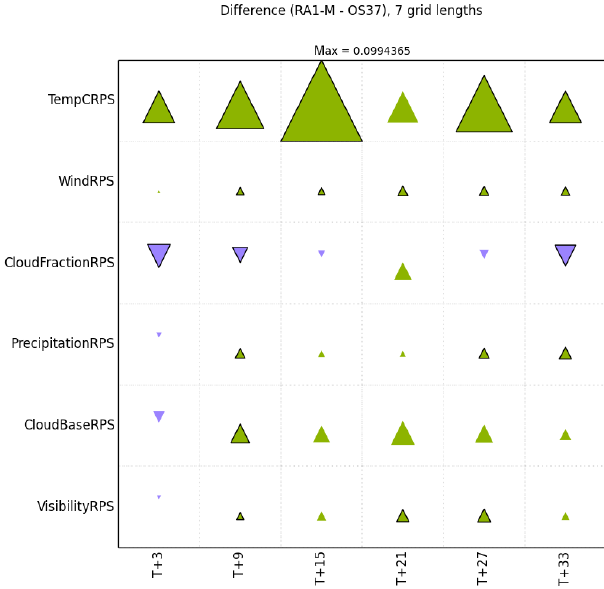
Figure 4. Case studies: RAL1-M vs. RAL0 HiRA summary score- card at a 10.5km (seven grid lengths) spatial scale. HiRA uses syn- optic observations (see Sect.